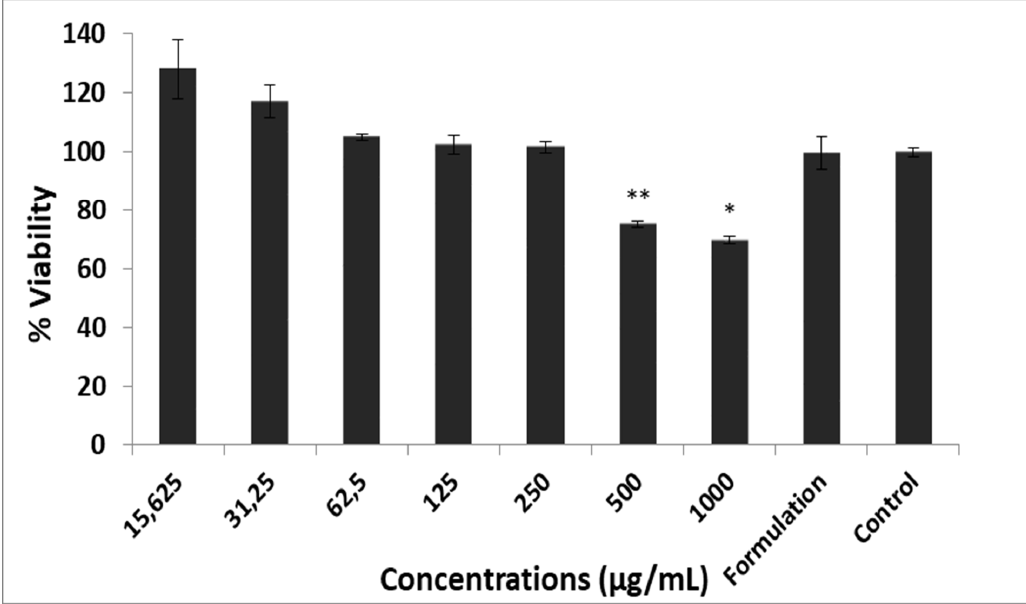
Figure 6. Toxicity effects of 70% MeOH extract and liposome formulation: Values given as mean ± SD were specified in the ±95% confidence interval ( n = 3). Statistical analyses were by Games–Howell comparison test, and significant differences were reported as * p < 0.01; ** p < 0.05.